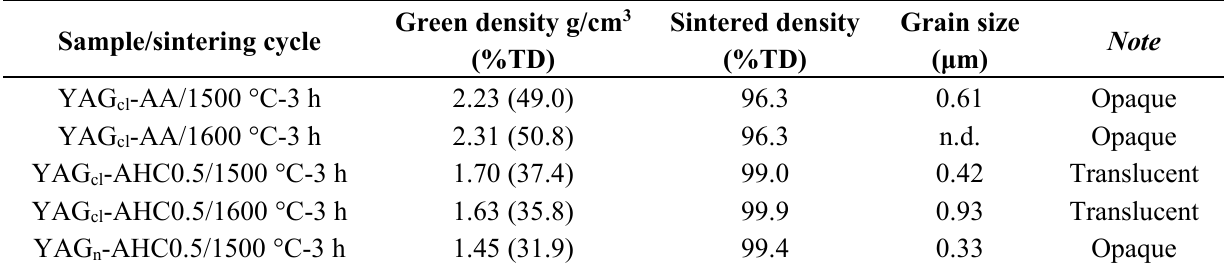
Table 2. Green and sintered density of the samples. In Note , the optical appearance of the